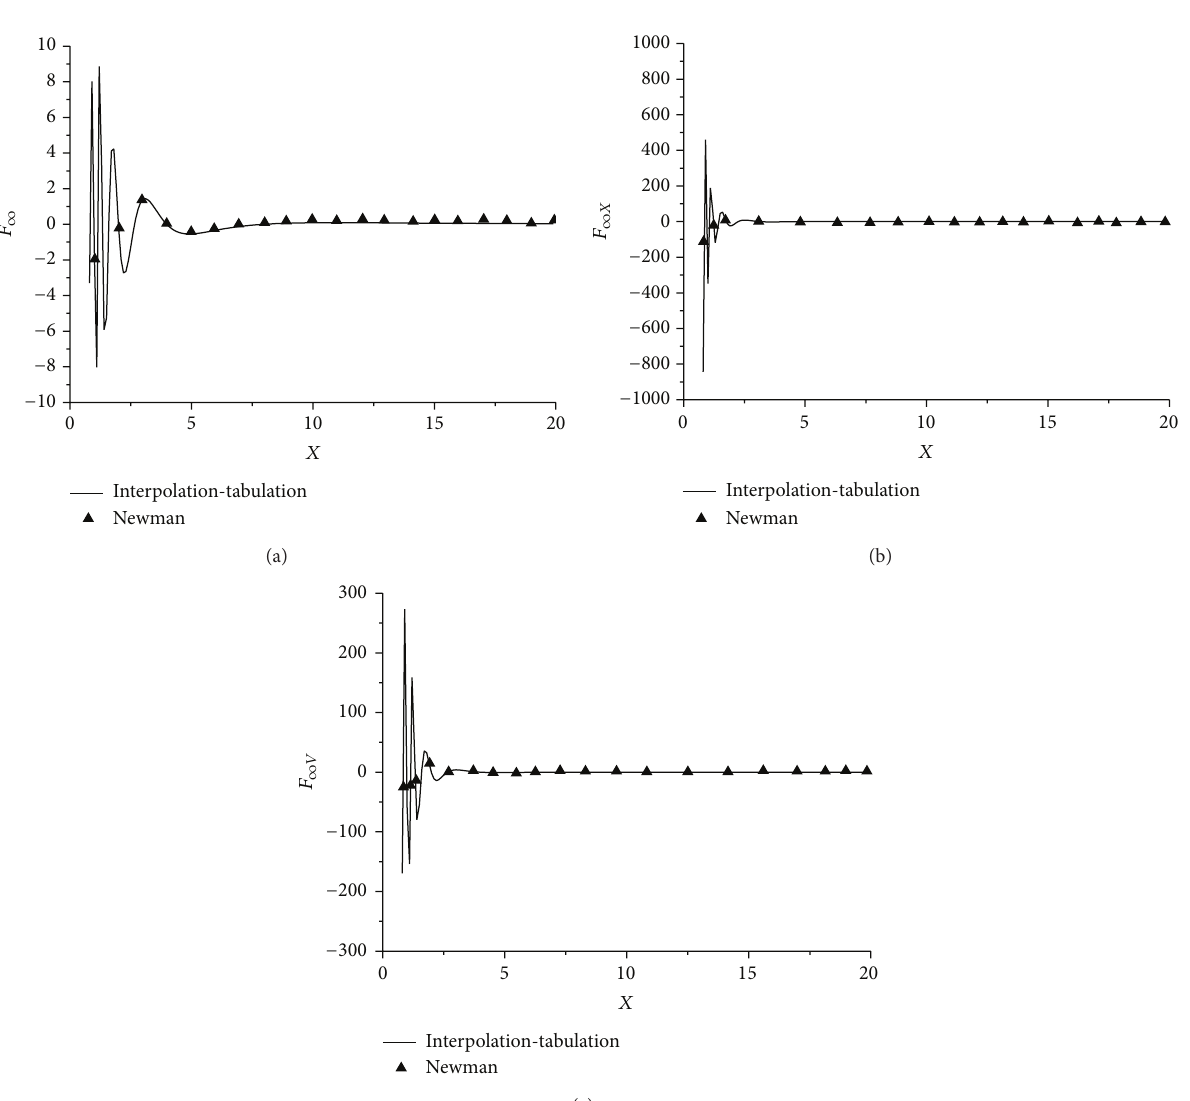
the left side of the VLFS and then the weight drops later by three cycles of the wave period. The wave length is 1.0 m, wave period is 0.8 seconds, wave height is 1 cm, and incident angle is 0